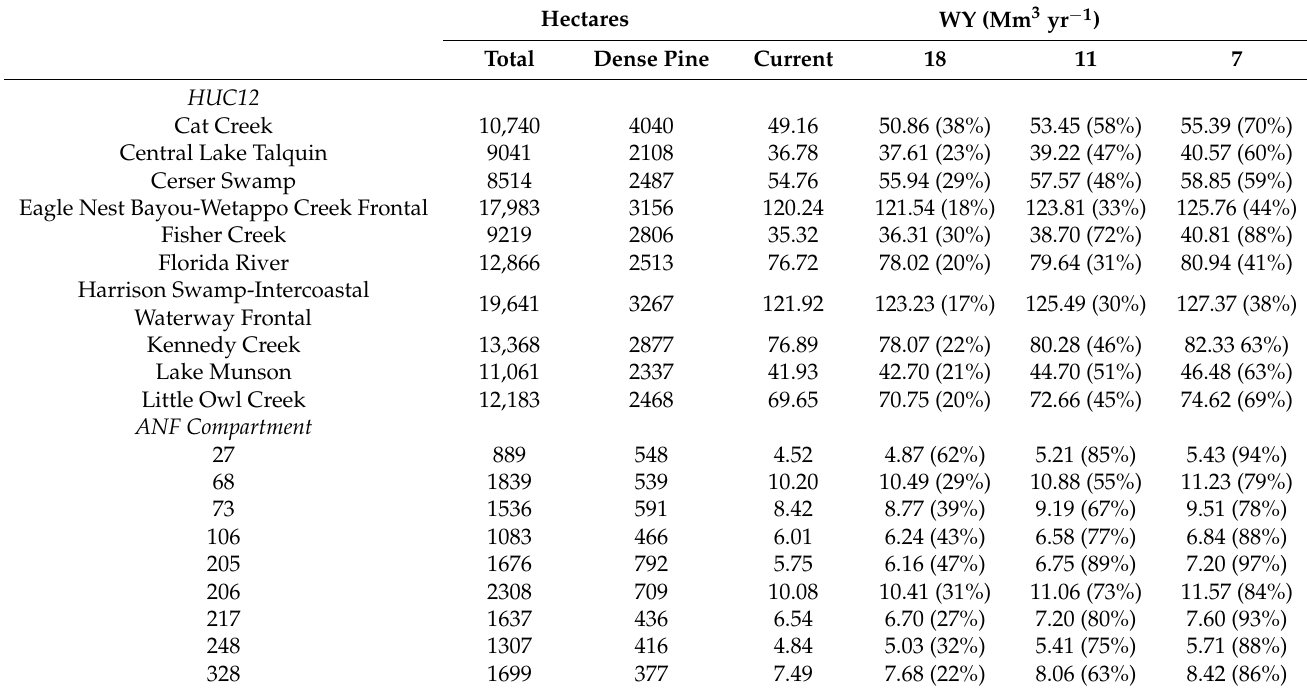
Table 3. Summary of HUC12s and ANF compartments with the highest PWYG from three timber thinning scenarios to maximum BA values of 18, 11, and 7 m 2 ha − 1 , total area and area of dense pine stands (BA ≥ 18 m 2 ha − 1 ) in hectares, and annual WY in millions of cubic meters per year (Mm 3 yr − 1 ). Proportion of area that exceeds each timber thinning threshold included (%) next to annual